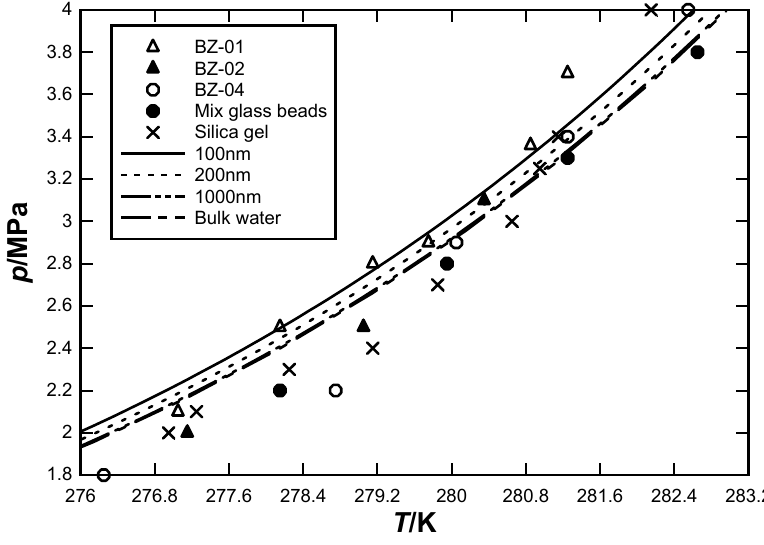
Figure 9. Comparison of measured and calculated equilibrium condition data for CO hydrate in different porous media.